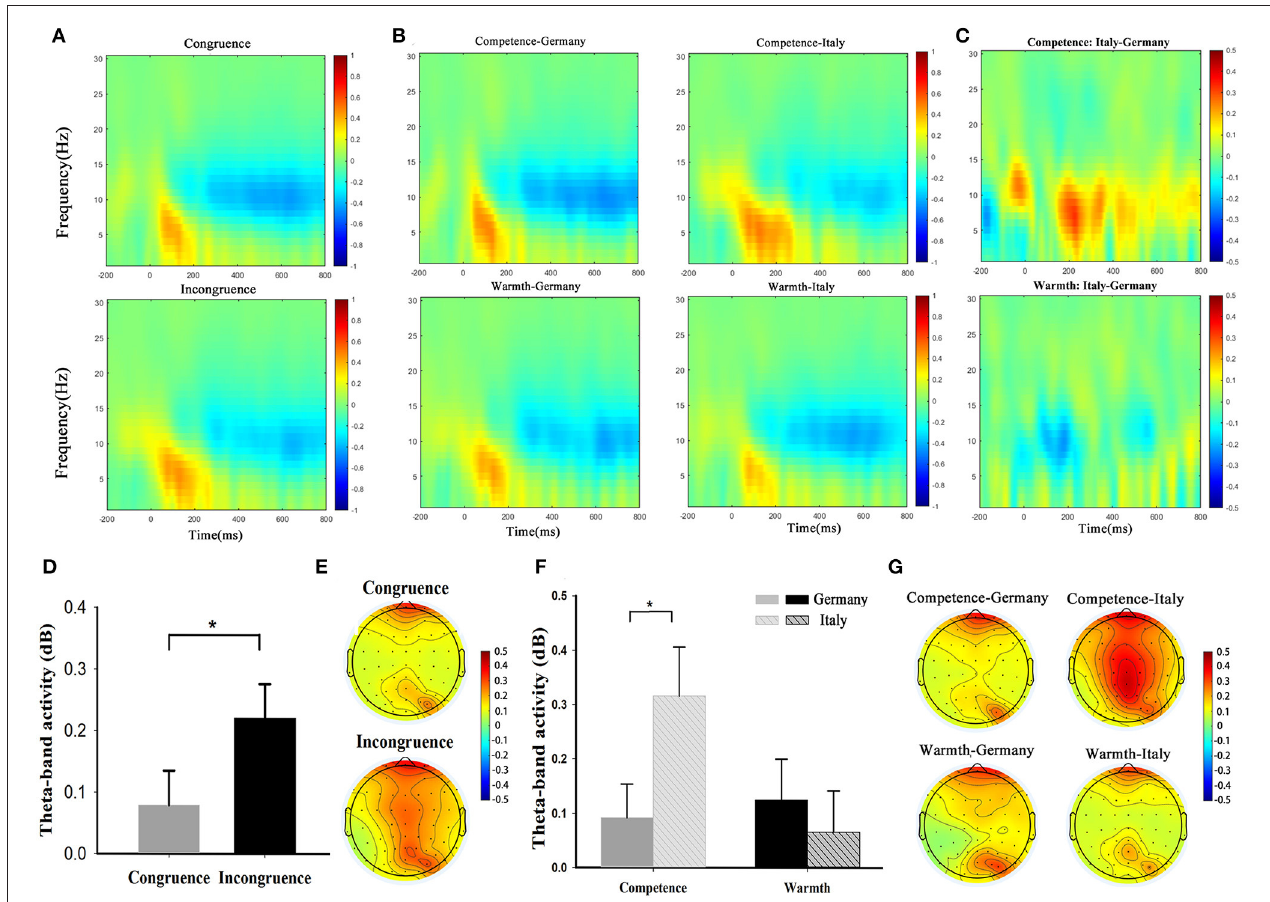
FIGURE 3 | Neural oscillation results. A/B/C Illustration of theta-band oscillations over the frontal ROI under the congruence and incongruence condition (A) , four conditions (B) , brand positioning difference (C) . (D,F) Bar graph. (E,G) Scalp topographic map. Error bars represent standard error across participants. Asterisk denotes a significant difference. Error bars indicate standard error across participants. * p <